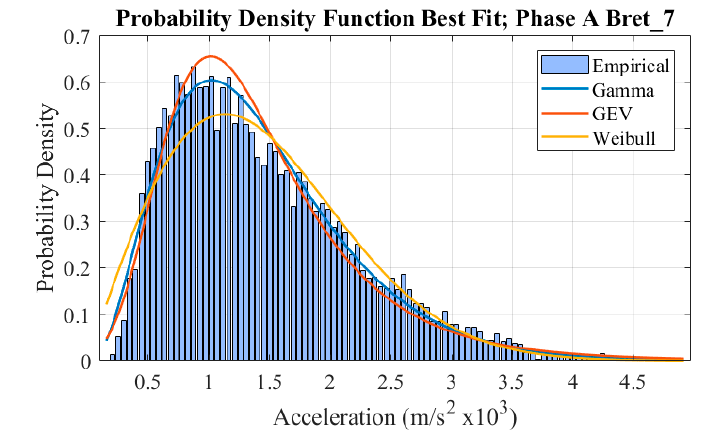
Table 6. Percentage difference of each Bayesian information criterion (BIC) value from best fit BIC value for different distributions for all Phase A tests.